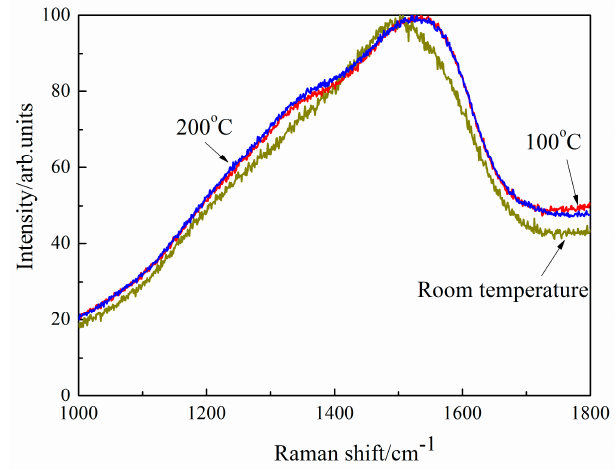
Figure 9. Raman spectra of DLC films on the flat under different temperatures.